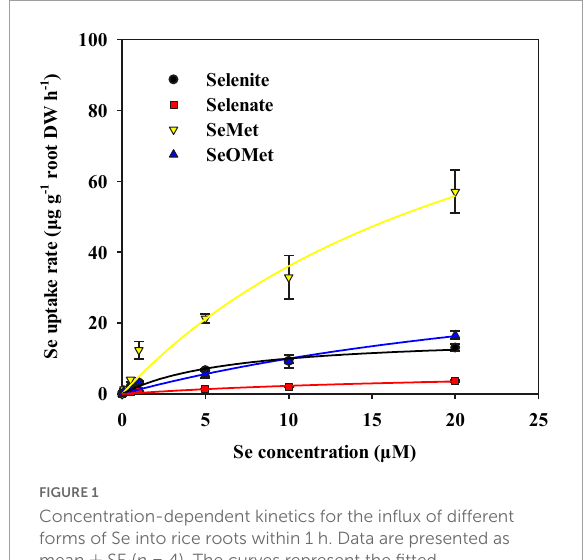
FIGURE1 Concentration-dependent kinetics for the influx of different forms of Se into rice roots within 1 h. Data are presented as mean ± SE ( n = 4). The curves represent the fitted Michaelis–Menten kinetics.